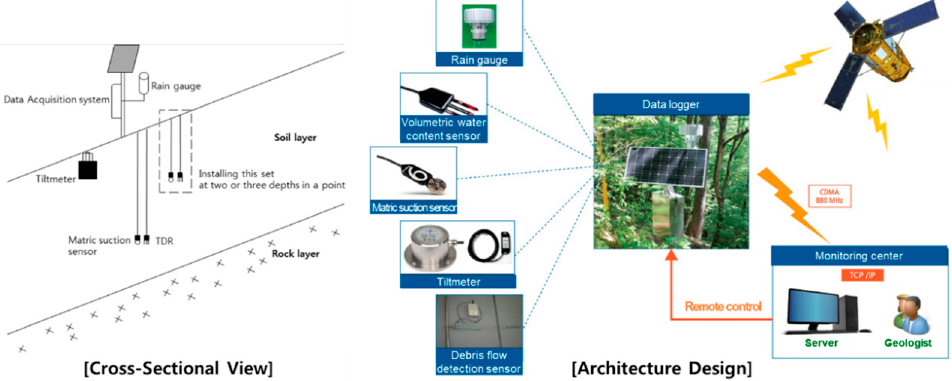
Figure 1. Configuration of KIGAM-LAMOS at a particular monitoring station.